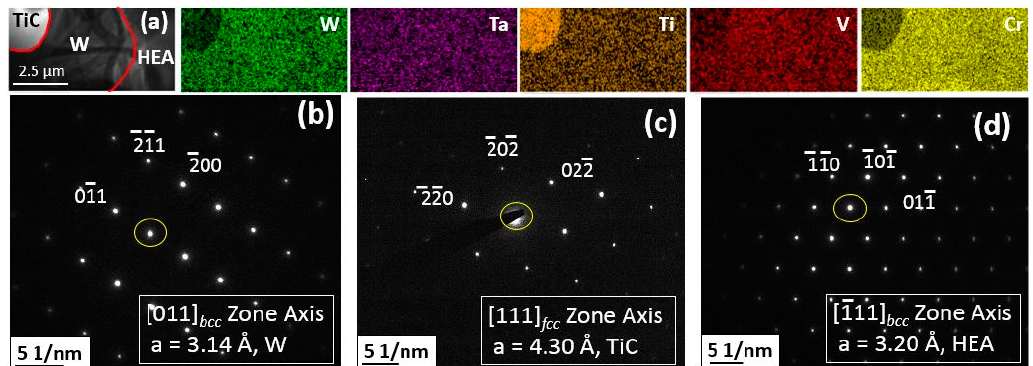
Figure 2. ( a ) Transmission electron microscopy (TEM)-energy dispersive X-ray spectroscopy (EDS) and selected-area electron diffraction (SAED) patterns of ( b ) W-rich, ( c ) TiC, and ( d ) HEA phases observed in W 0.5 (TaTiVCr) 0.5 .